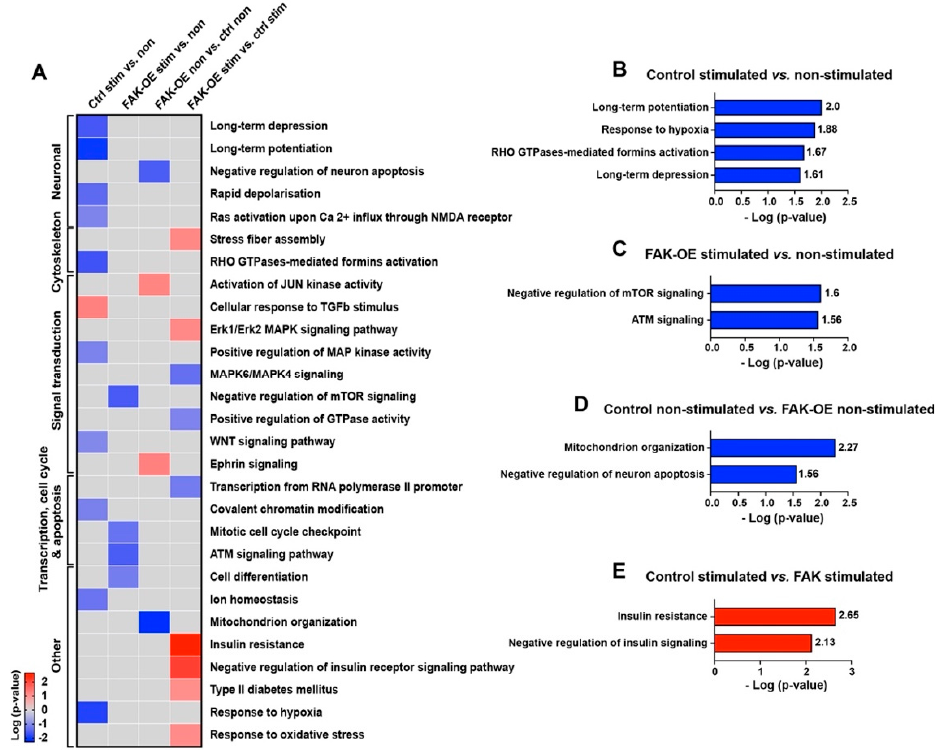
Figure 7. Overexpression of FAK mediates AD-like phenotypes in 3xTg-AD mice by control- ling the PI3K and insulin signaling pathways, re-entry into the cell cycle, and neuronal cell death. ( A ) Heatmap of enriched pathways from the antibody microarray assay. Pathways that showed a change in only one group and contained five proteins or more are presented in the heatmap. ( B – E ) Selected enriched pathways in each of the four pairwise comparisons: Con- trol stimulated vs. non-stimulated ( B ), FAK-OE stimulated vs. non-stimulated ( C ), FAK-OE non- stimulated vs. control non-stimulated ( D ), and FAK-OE stimulated vs. control stimulated ( E ). Pathways with a score of p ≤ 0.5 (log p -value ≥ 1.3) were selected and are discussed in the